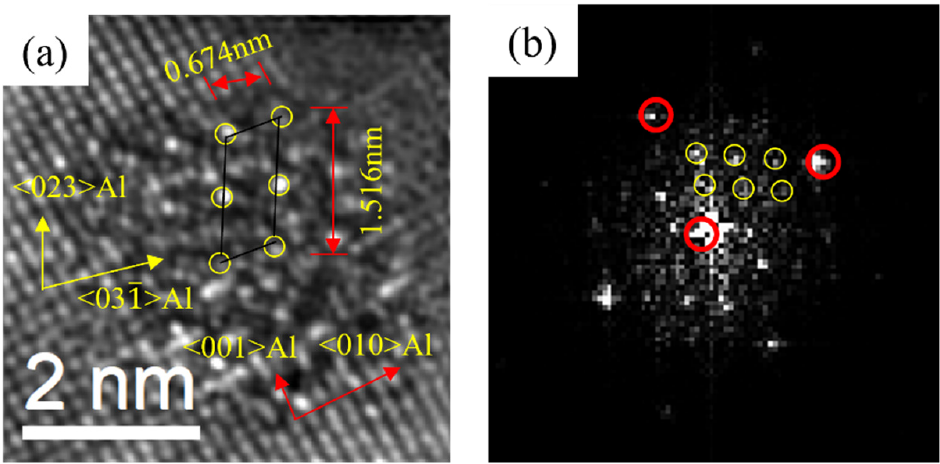
Figure 9. HRTEM ( a ) and FFT ( b ) patterns of the β″ phase of 0Cu alloy after peak aging at 175 °C for 12 h.